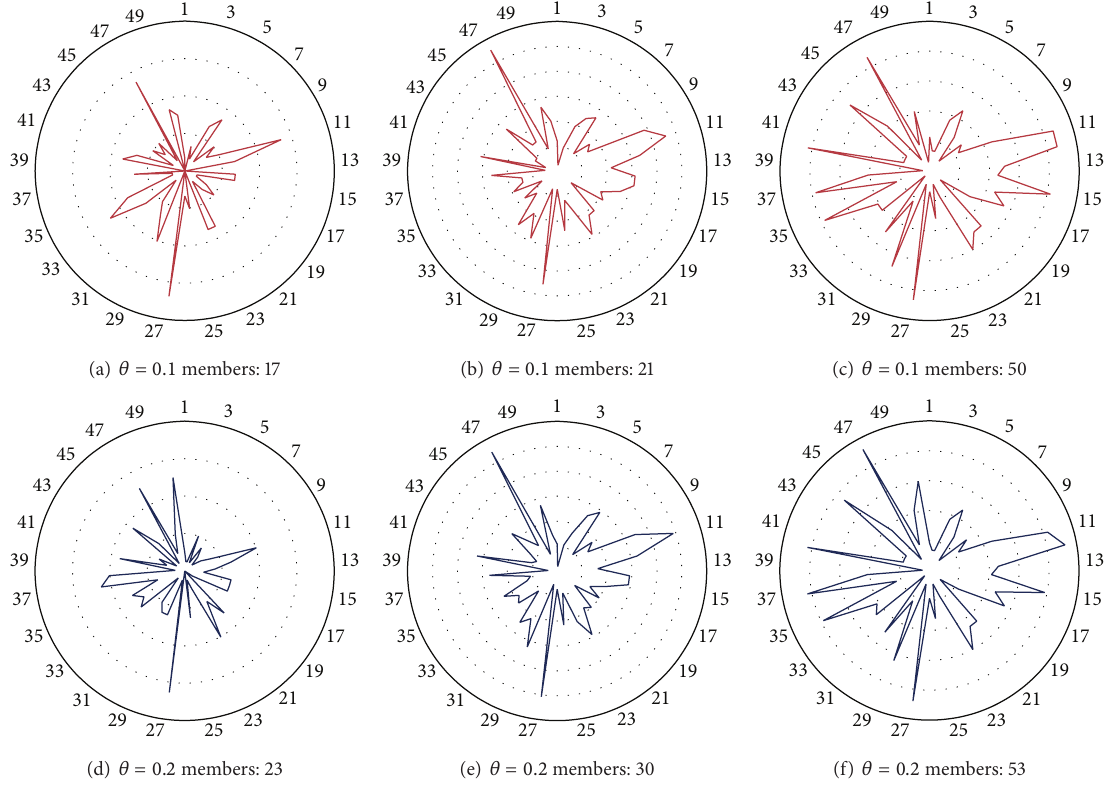
Figure 4: Content community pattern of the three largest communities detected through TPA on 2005-VC.